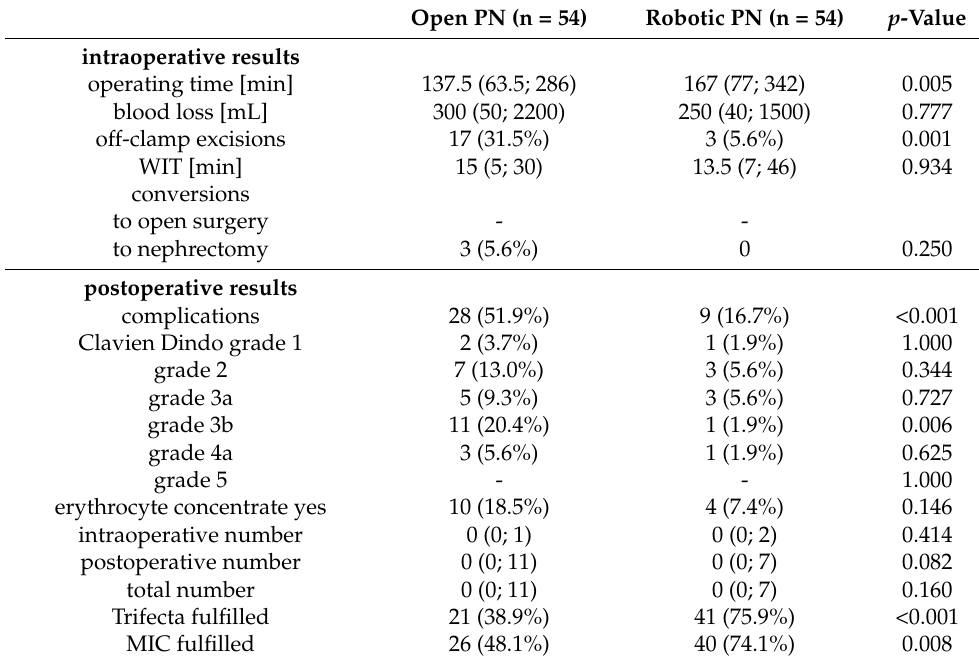
Table 2. Comparison of the perioperative outcomes of open vs. robot-assisted partial nephrectomies (PN) after propensity score